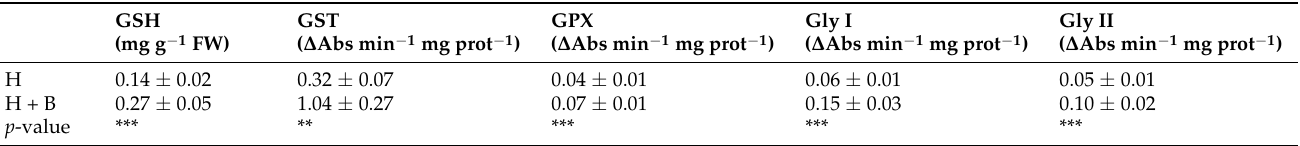
Table 3. GSH homeostasis in sunflower plants subjected to the